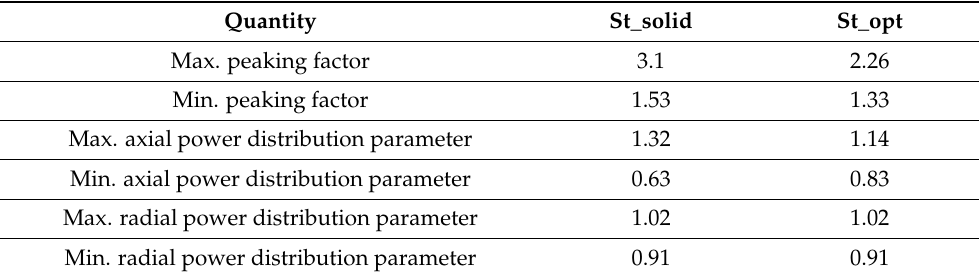
Table 7. Summary of the simulation